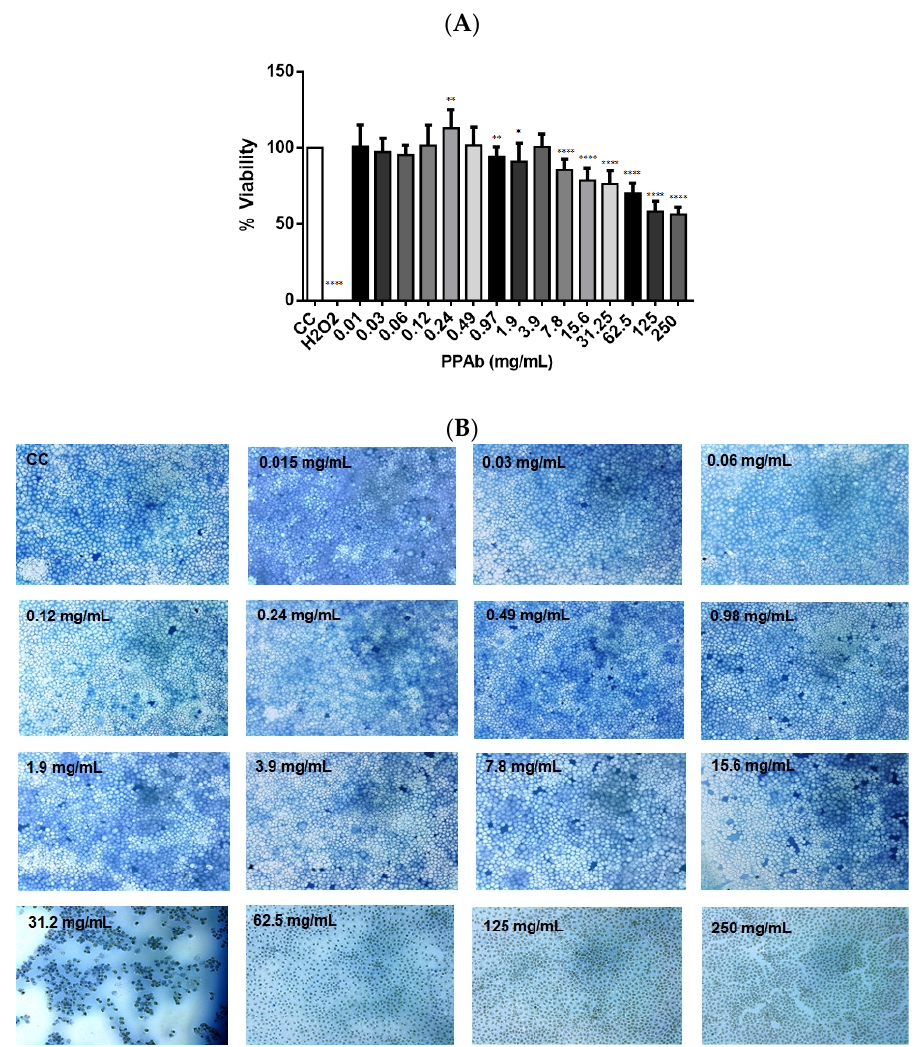
Figure 1. Cytotoxic effect of the PPAb on MA104 cells. MA104 cells were exposed to different concentrations of PPAb for 48 h. ( A ) Cell viability was assessed by MTT assay. CC: cell control (non-PTP treated cells); H 2 O 2 : cytotoxicity control. Bars represent mean ± SD. * p < 0.05, ** p < 0.008, **** p < 0.0001; unpaired Welch’s t -test for comparisons with the CC control; ( B ) Cell viability was evaluated by the trypan blue dye exclusion test. Representative photographs (100X). Both tests were done in triplicates and repeated independently three times.